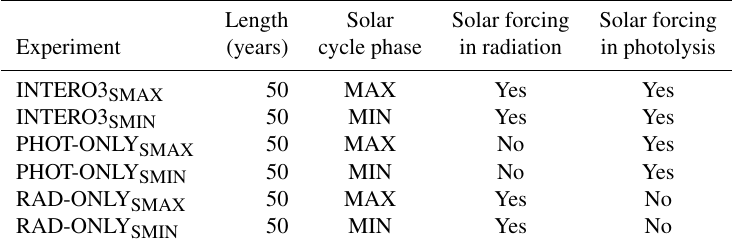
Table 1. Summary of the sensitivity time-slice experiments performed. Length Solar Solar forcing Solar forcing Experiment (years) cycle phase in radiation in